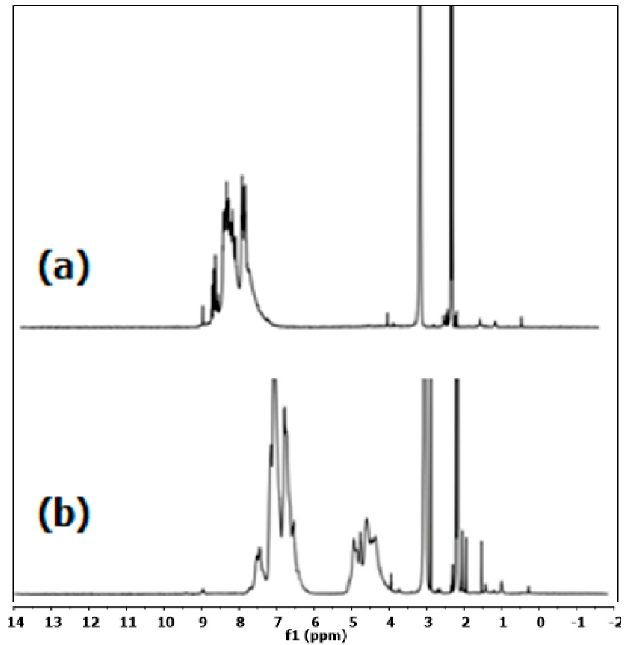
Figure 4. 1 H-NMR spectra of ( a ) ONPS and ( b ) OAPS.